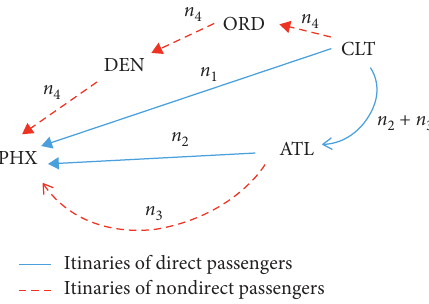
Figure 1: Illustration of the definition of O&D direct